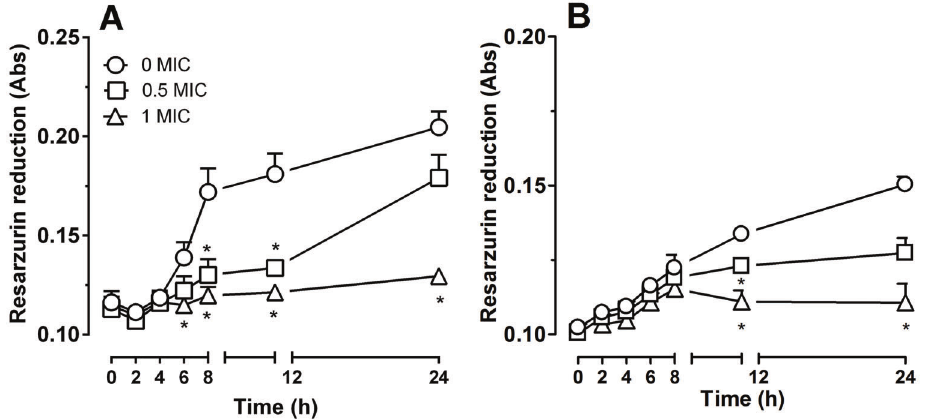
Figure 4. Effect of ethanolic extracts of propolis from M. quadrifasciata quadrifasciata on growth curve assay. Absorbance readings for assays with S. aureus ( A ) and E. coli ( B ). Data are reported as means ± SE of three independent experiments performed in triplicate. *P o 0.05 compared to respective control ( t -test). Table 2. Effect of ethanolic extracts of propolis (EEP) from M. quadrifasciata quadrifasciata on cell constituents release of S. aureus and E. coli after 4 h.